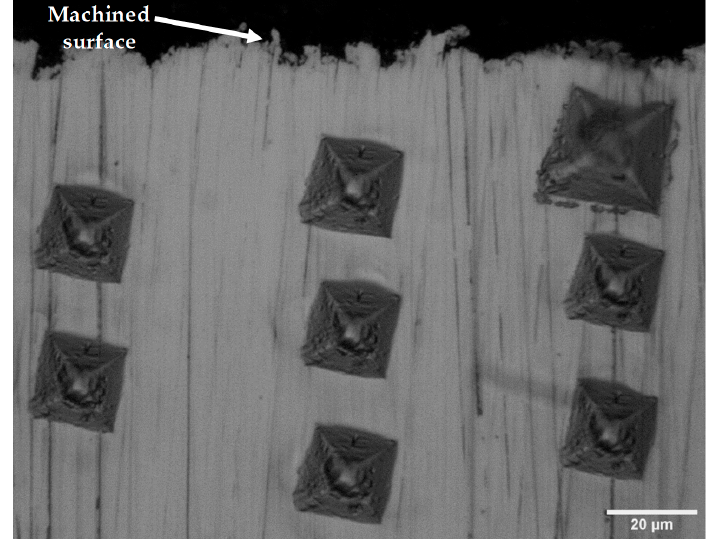
Figure 11. WEDM machined Sub-surface microhardness indents.